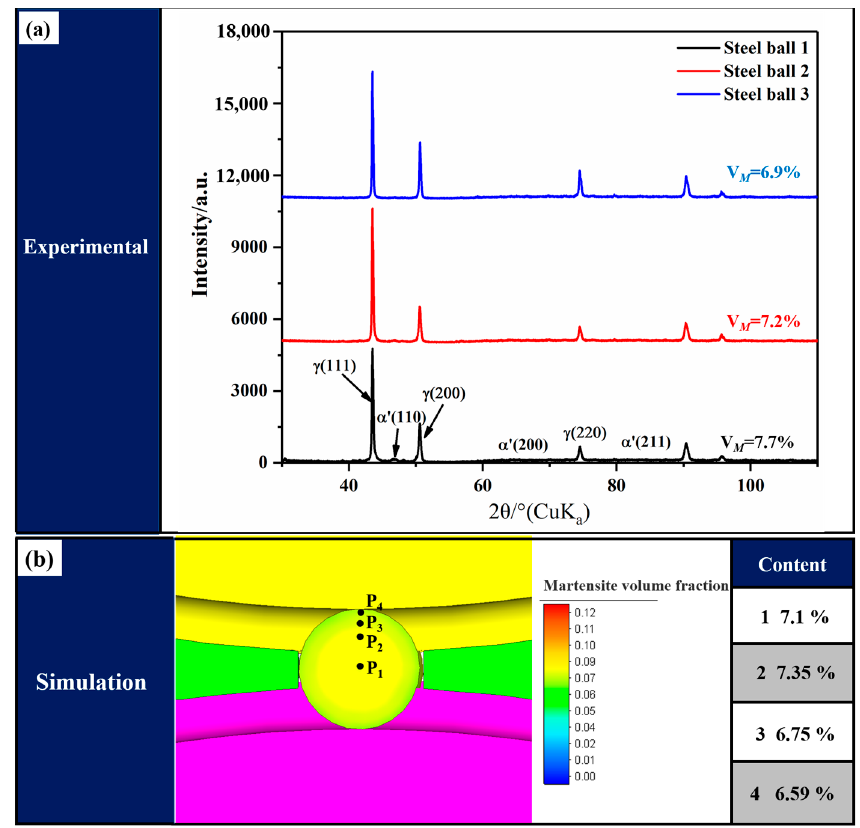
Figure 5. Comparison of volume fraction of martensite: ( a ) experimental results and ( b ) simulation results.